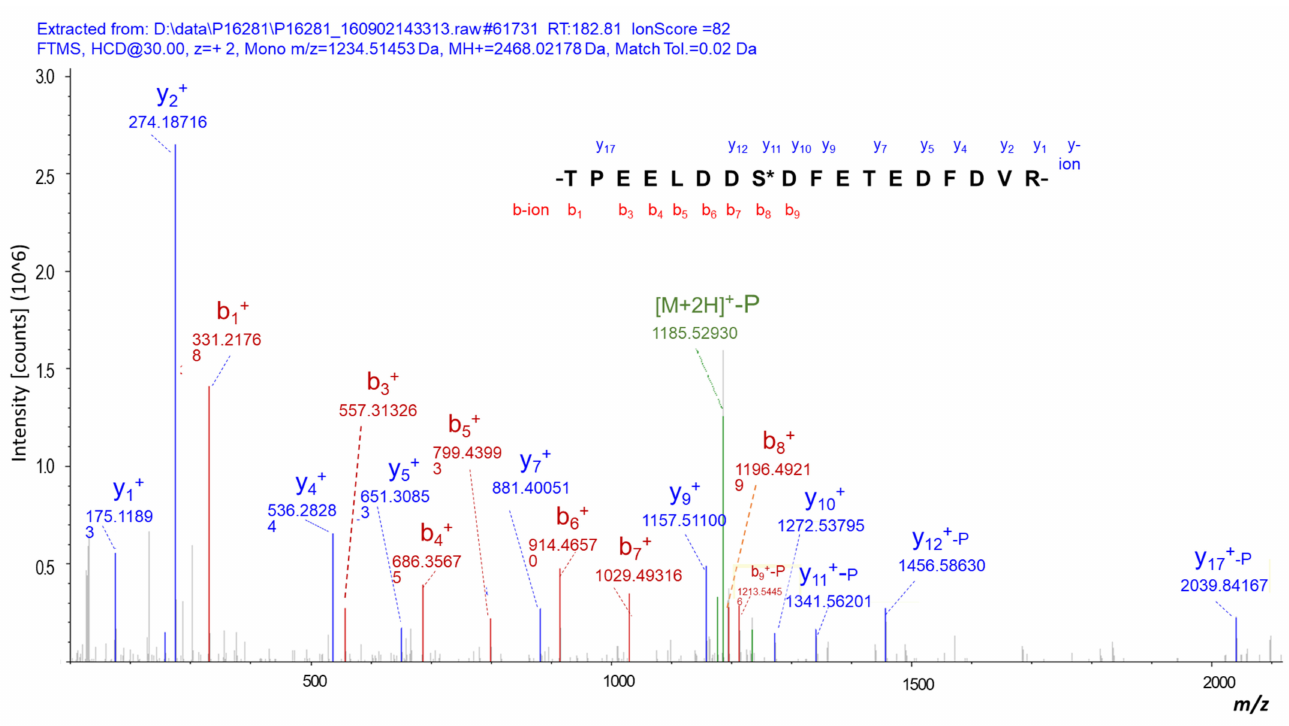
Figure 1. MS/MS spectrum of the representative peptide. The representative peptide 633 TPEELDDS*DFETEDFDVR 652 derived from catenin alpha-1 protein (P35221). The observed b- and y-ions were labeled in the MS/MS spectrum. S* = phosphorylated amino acid residue.